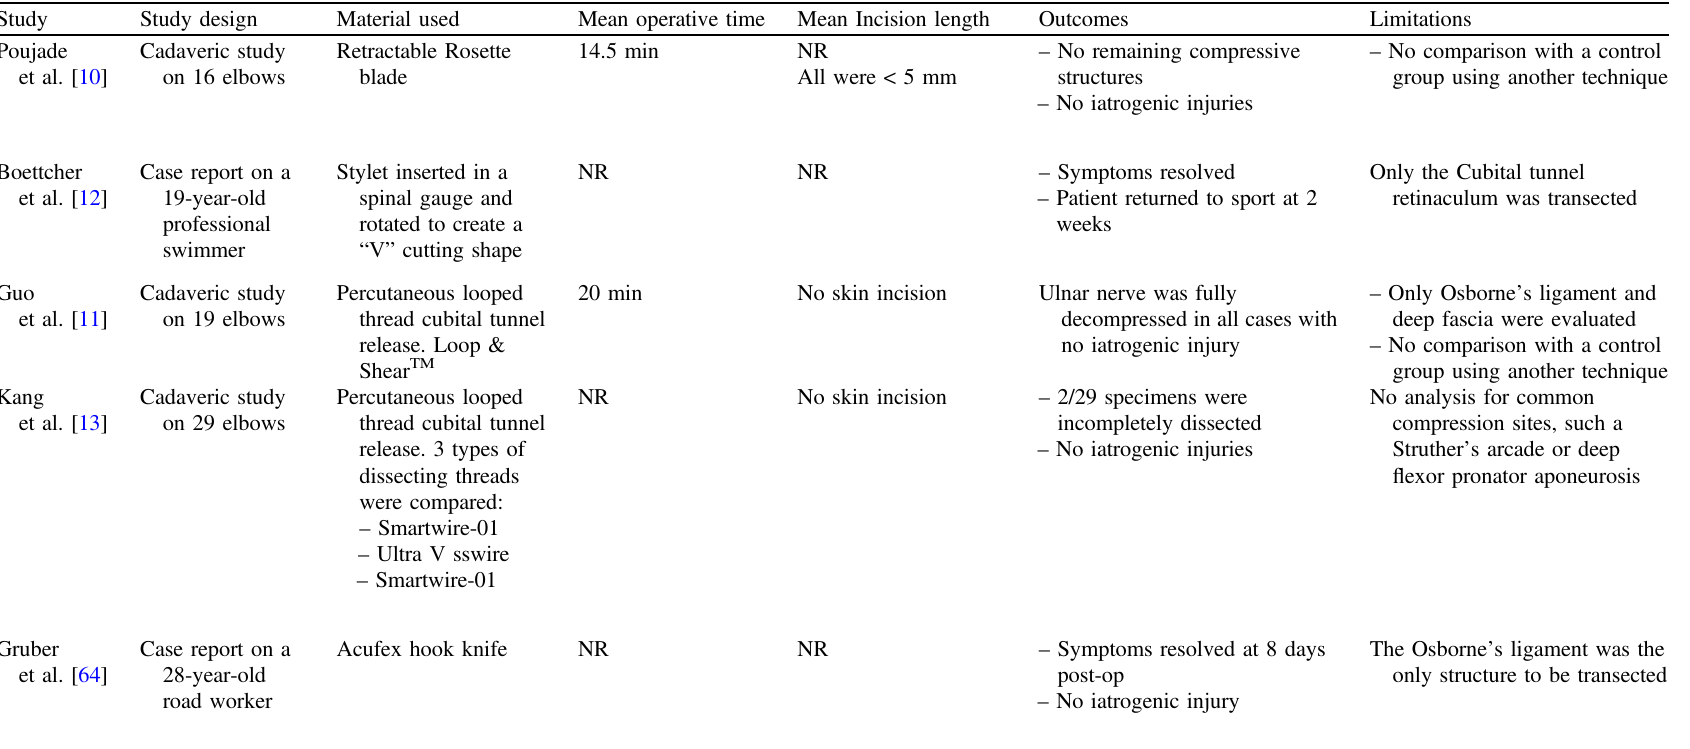
Table 3. Summary of current literature regarding US-guided CuTS release. NR: Not